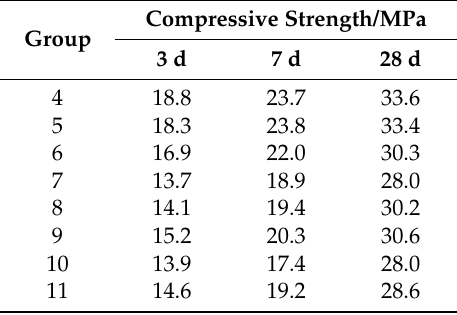
Table 2. Tested compressive strength of green concrete.